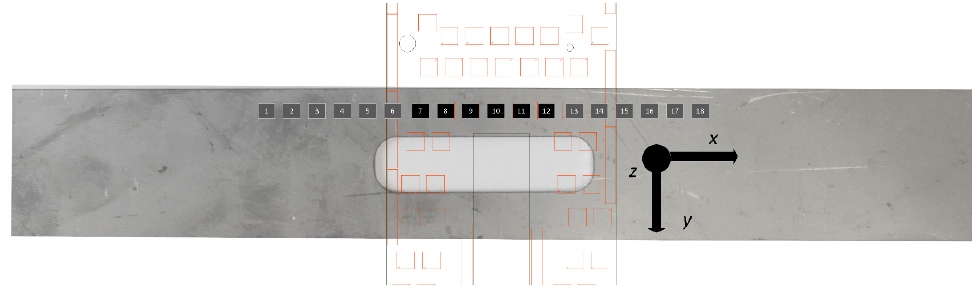
To enable coverage along the entire length of the sample, the experiment was per- formed several times by shifting the matrix of the sensors in relation to the tested sample in specific intervals after each experiment. The measurement points on the sample (mag- netic field measurement points subject to further evaluation) are illustrated in Figure 3. Figure 2. Image of the MagMouse measurement device [8]. Figure 2. Image of the MagMouse measurement device [8]. During the research, data from only one row of matrix sensors were used.